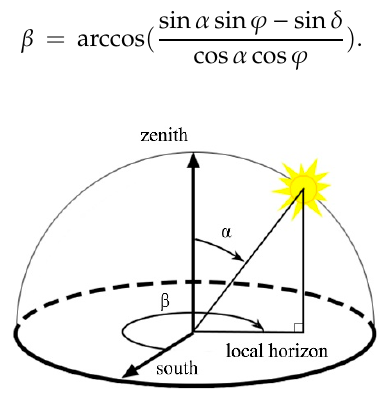
Figure 4. Spatial position of the sun.